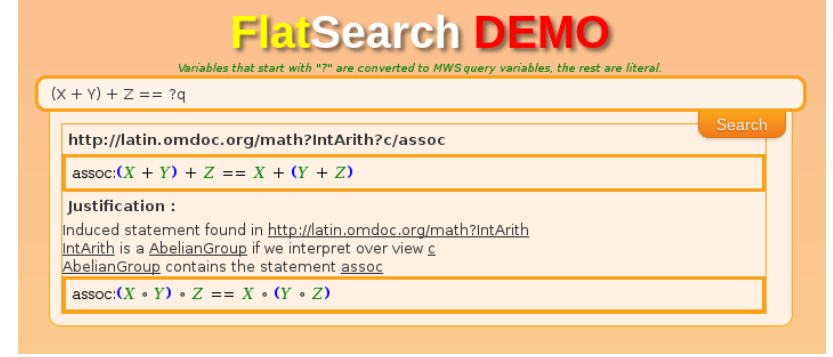
Fig. 6. (cid:91) search on a Theory Graph similar to the one in Figure